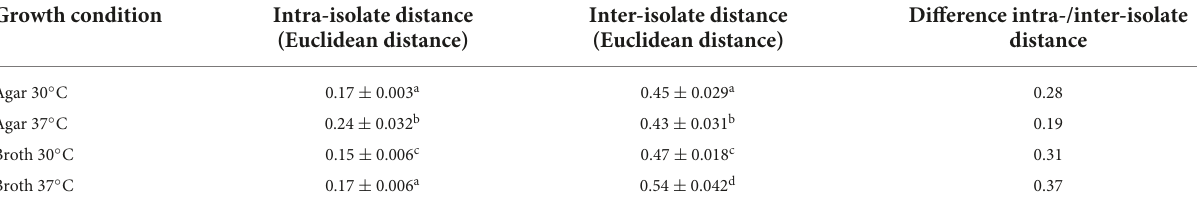
TABLE 2 Assessment of the validity of IR Biotyper R (cid:13) results for schemes 1 and 2. Growth